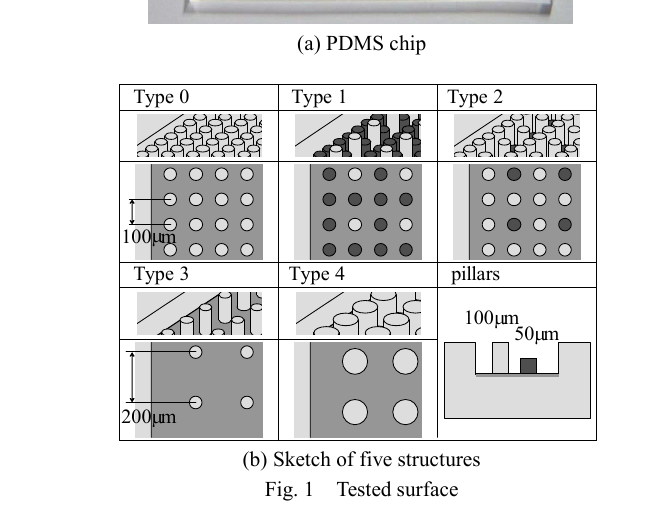
Table 1 Dimensions of pillars